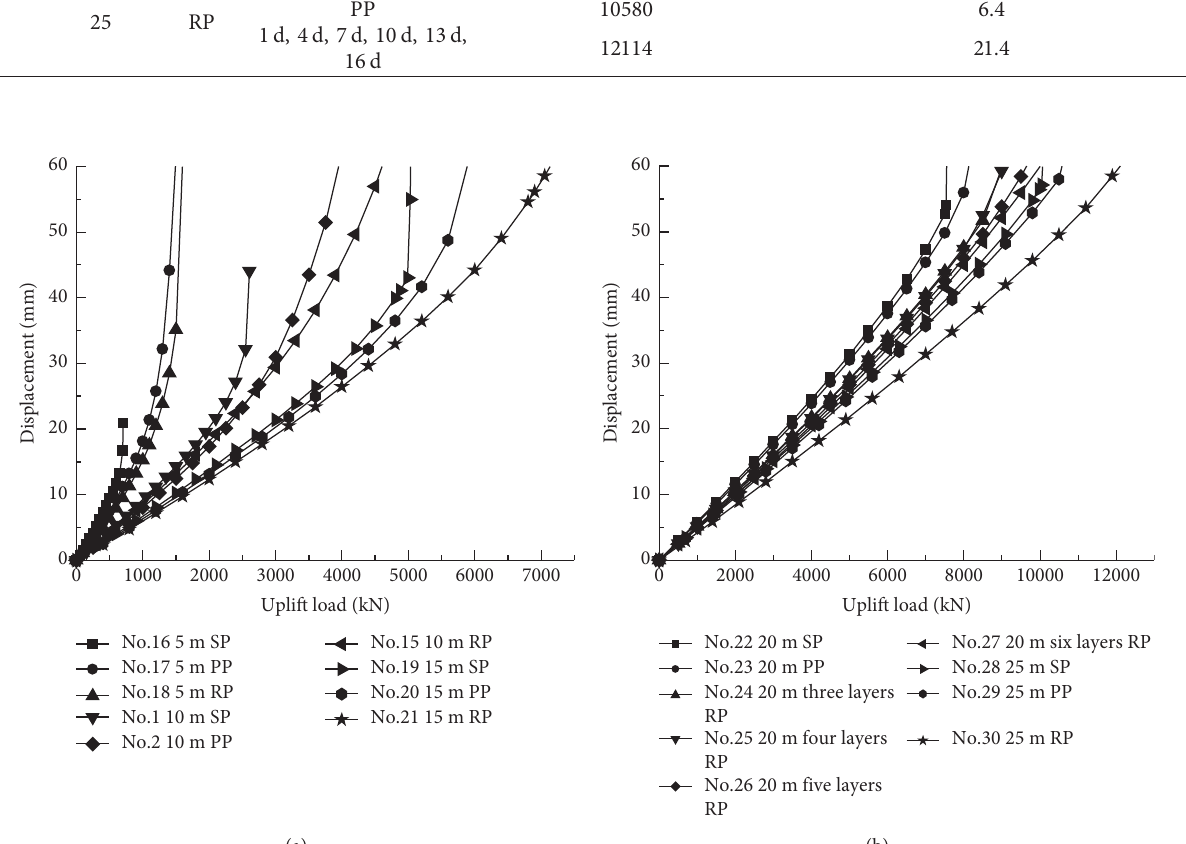
Figure 12: Uplift load displacement of piles with different length. (a) Pile length of 5, 10, and 15m. (b) Pile length of 20 and